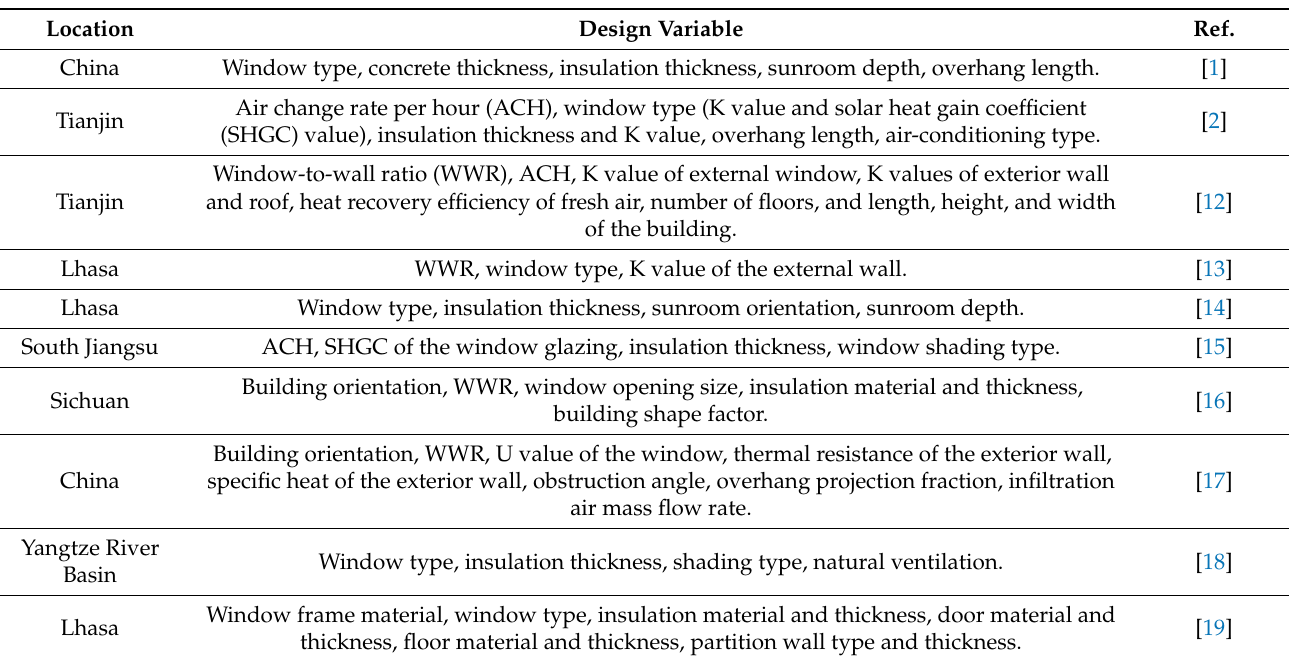
Table 1. Design variables for passive buildings and green roof optimization from open literature. Location Design Variable